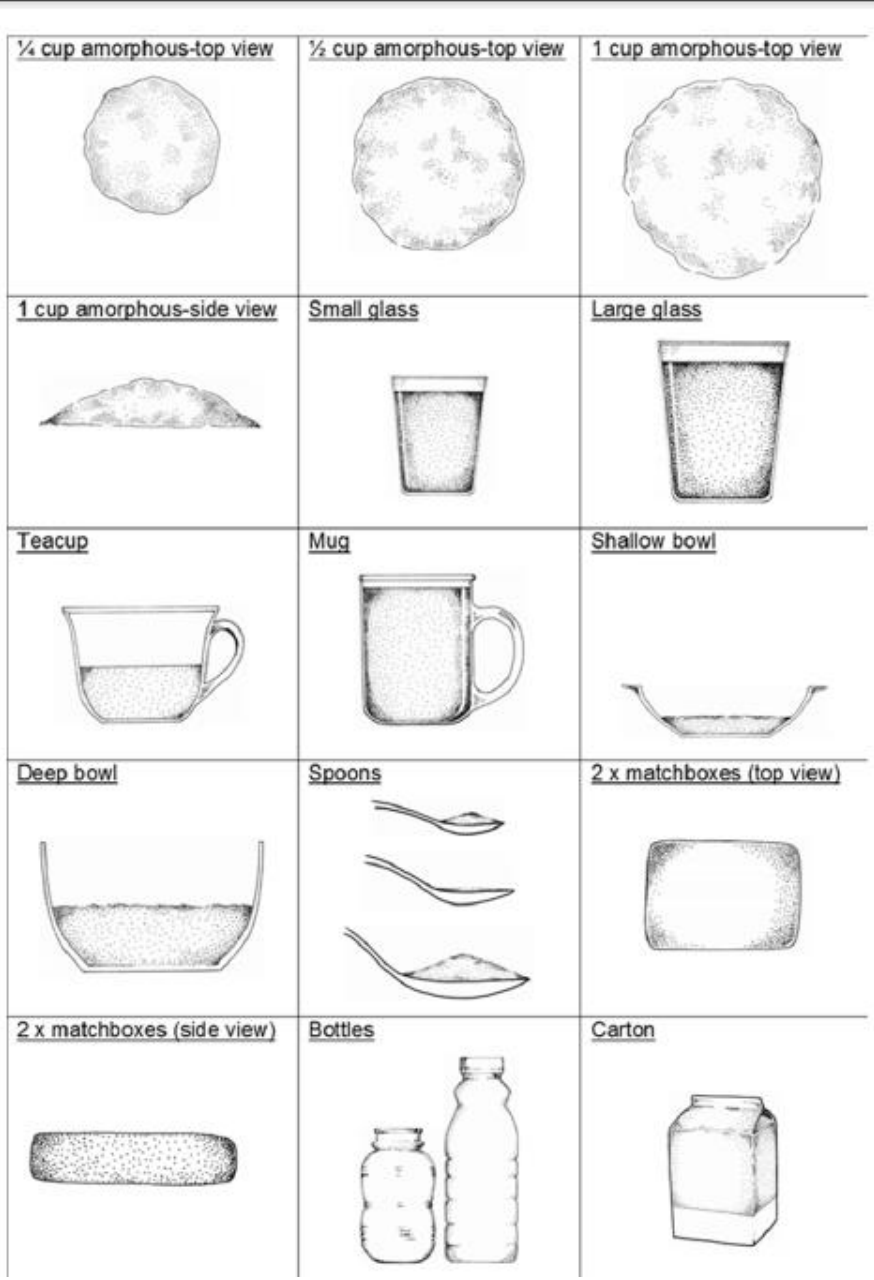
Figure A1. Examples of sketches and measures used in the current study [48].